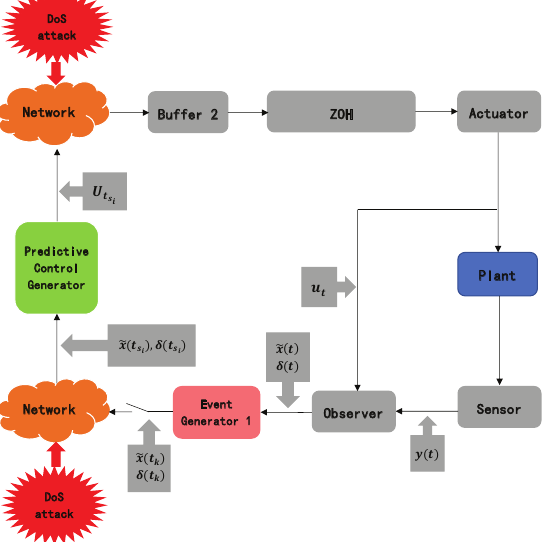
Figure 1. The diagram of the observer-based event-triggered predictive control (OB-ETPC) systems under denial-of-service (DoS)